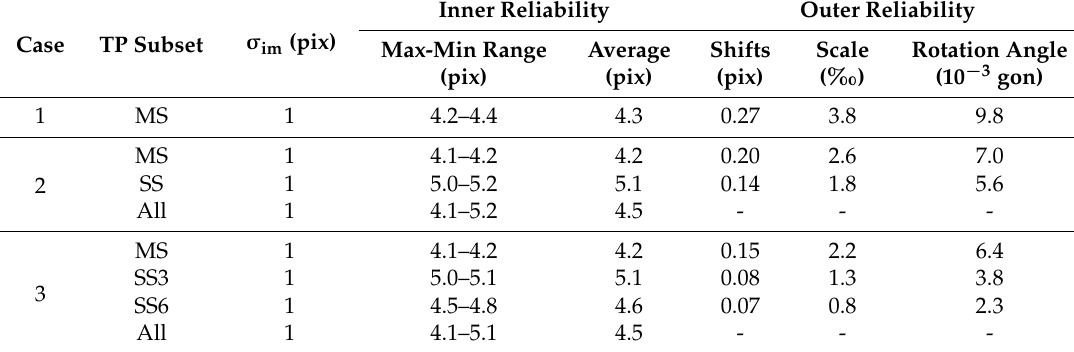
Table 2. Inner and outer reliabilities computed for the simulated Cases 1, 2, and 3. In the second column, the subset of TPs adopted for evaluating the inner/outer reliabilities are described using the following symbols: ‘MS’ is the subset of TPs shared between the ‘master’ and one or more ‘slaves’; ‘SS’ is the subset of TPs shared between two or more ‘slaves’; ‘All’ is the subset including all types of TPs.